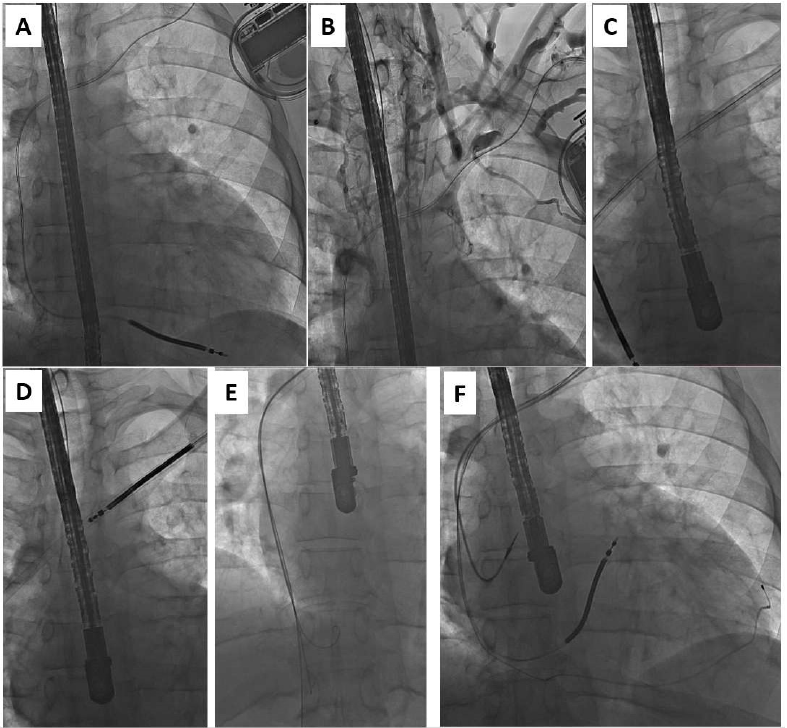
Figure 3. Upgrade from ICD-V ( A ) to CRT-D in the patient with lead-related venous obstruction ( B ). Moving the preparation sheath over the lead to the heart allows not only for lead removal ( C , D ) but also reestablishing venous access ( E ) for the implantation of three new leads ( F ). The present study also evaluated the survival of patients undergoing lead extraction.